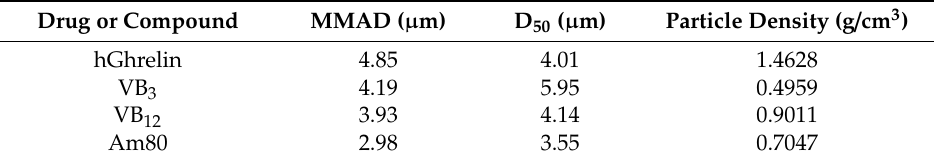
Table 1. Particle density calculated from MMAD and D 50 .